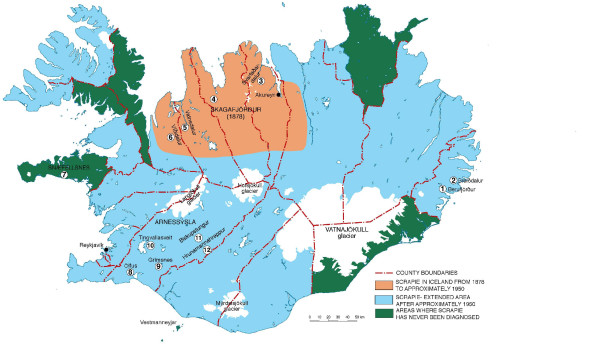
Scrapie in Iceland and locations of farms. Scrapie was, from its presumed origin in Skagafjörður in the year 1878, confined to a part of northern Iceland until ca. 1950 (orange). It has since spread patchily to greater or lesser parts of all counties (blue) except for four (green). The numbers 1–12 indicate the twelve different locations of the 41 farms in all scrapie categories where 756 blood samples were collected for the analysis of GPX activity. Farm A is located in the green county (Snæfellsnes) numbered 7. The scrapie-free counties and the large green area in the north-east corner of the country are the main areas in the country used to provide healthy lambs to restock formerly scrapie-afflicted farms.